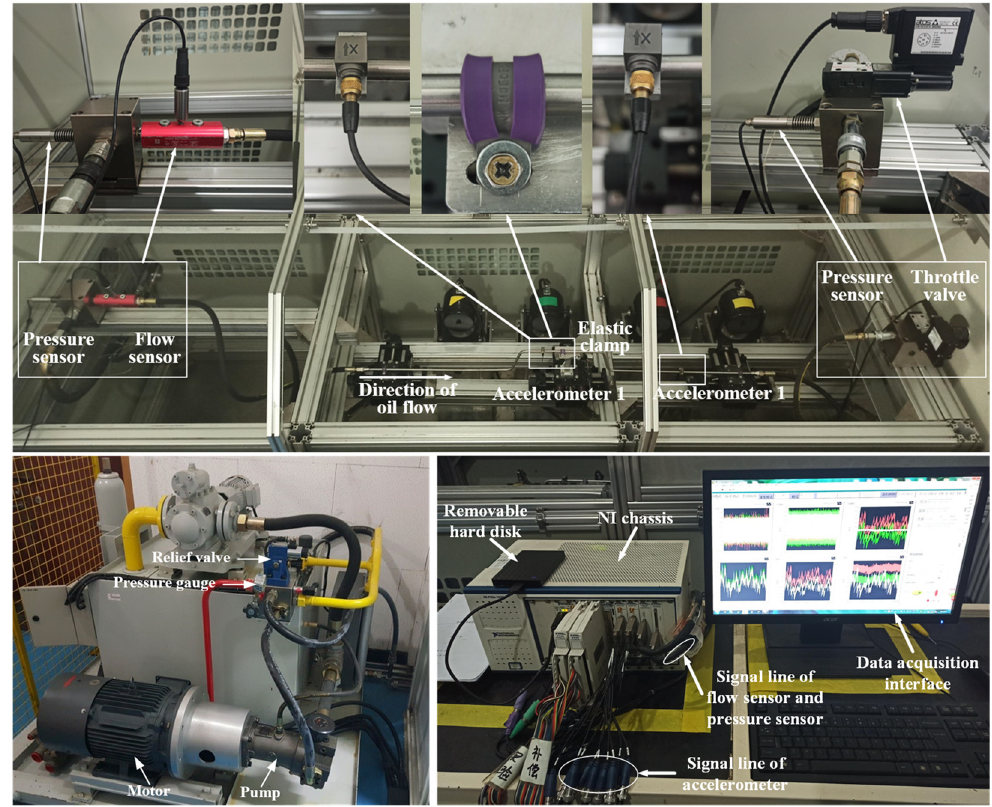
Figure 10. Experimental system and test stand